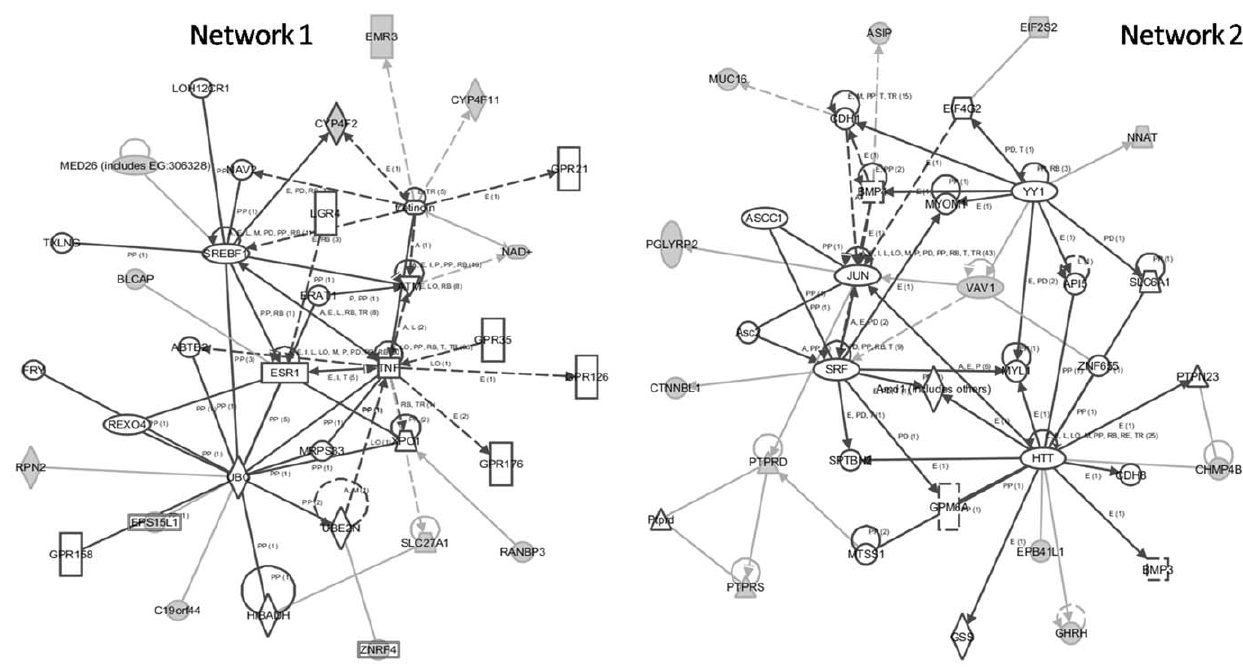
Figure 3. NBQC Networks: Molecular Transport, Nucleic Acid Metabolism, Small Molecule Biochemistry (Network 1) and Cellular Development, Embryonic Development, Organismal Development (Network 2). doi:10.1371/journal.pone.0043789.g003 Table 2. Significant signaling pathway networks observed in BQC, NBQC and Common altered genomic regions.